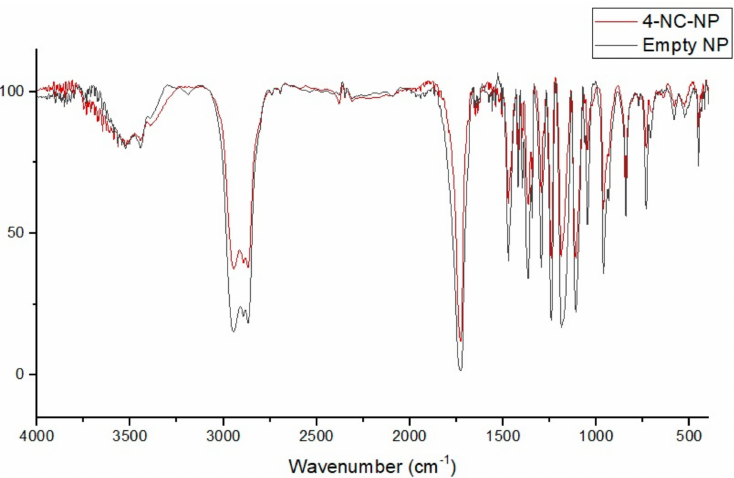
Figure 10. Comparison of 4-NC NP and empty NP FT-IR